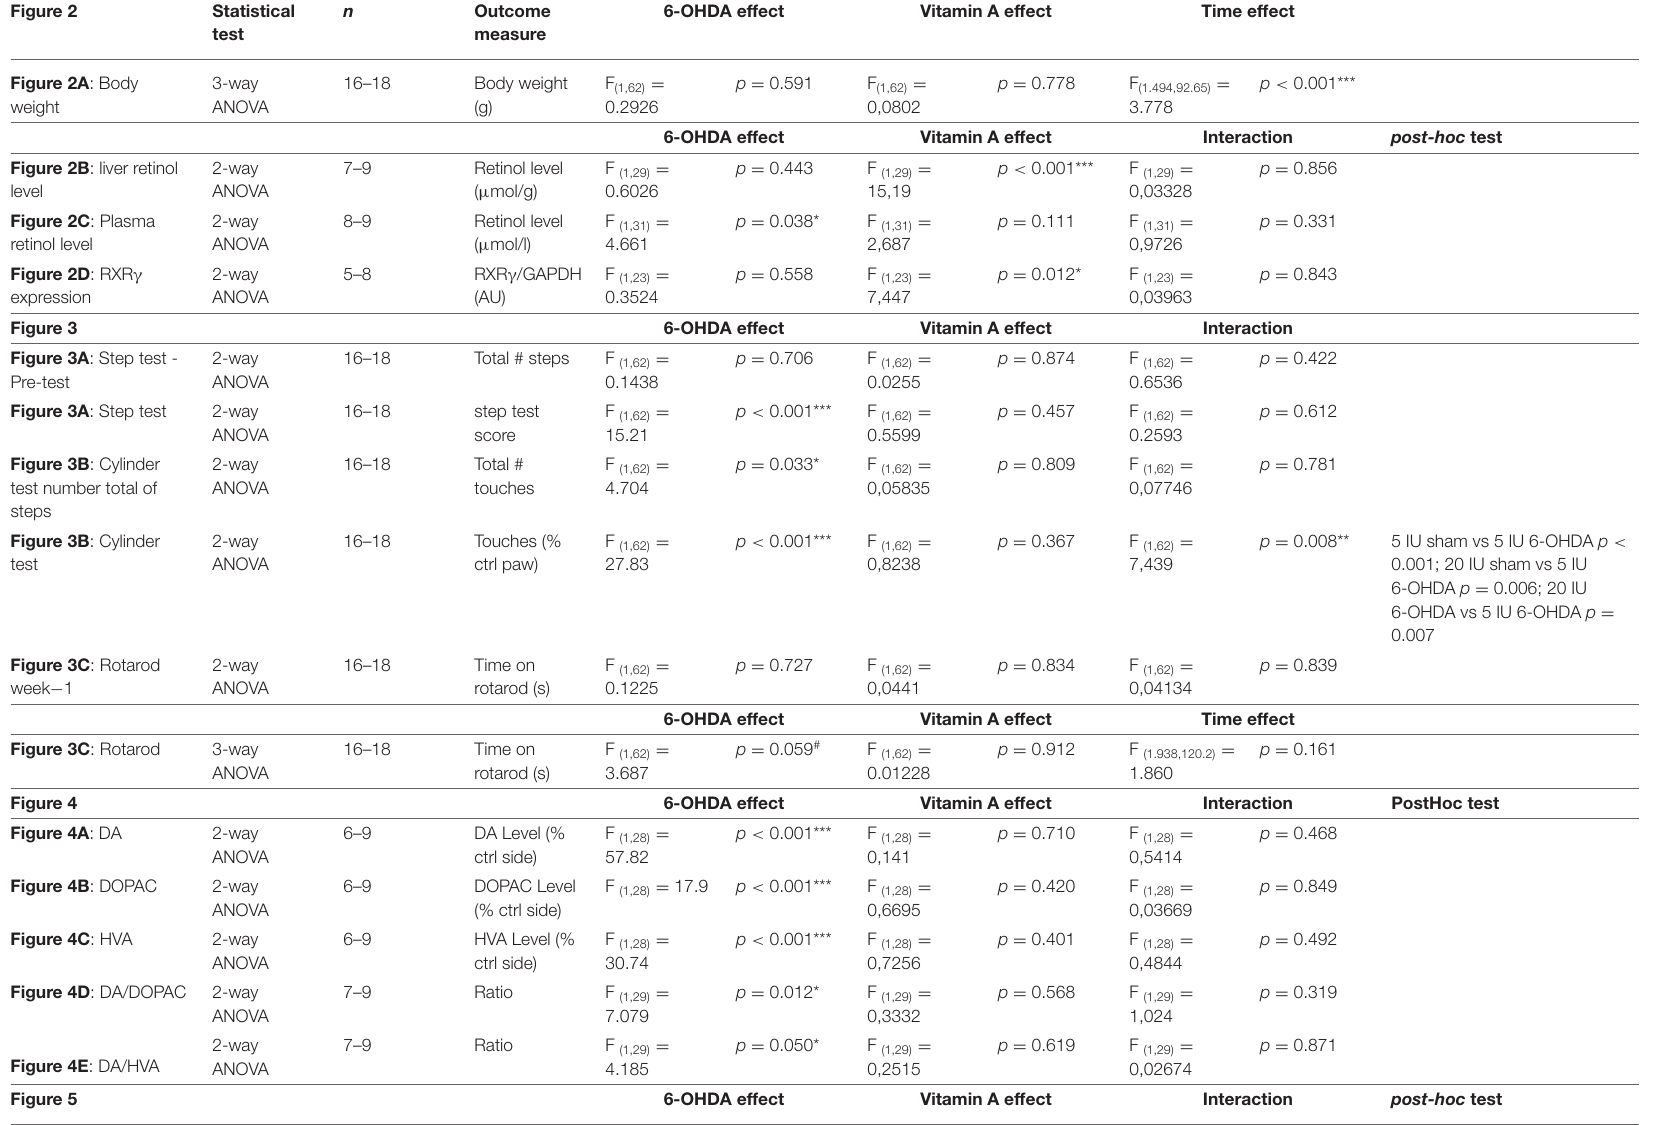
TABLE 3 | Summary of statistical analysis.